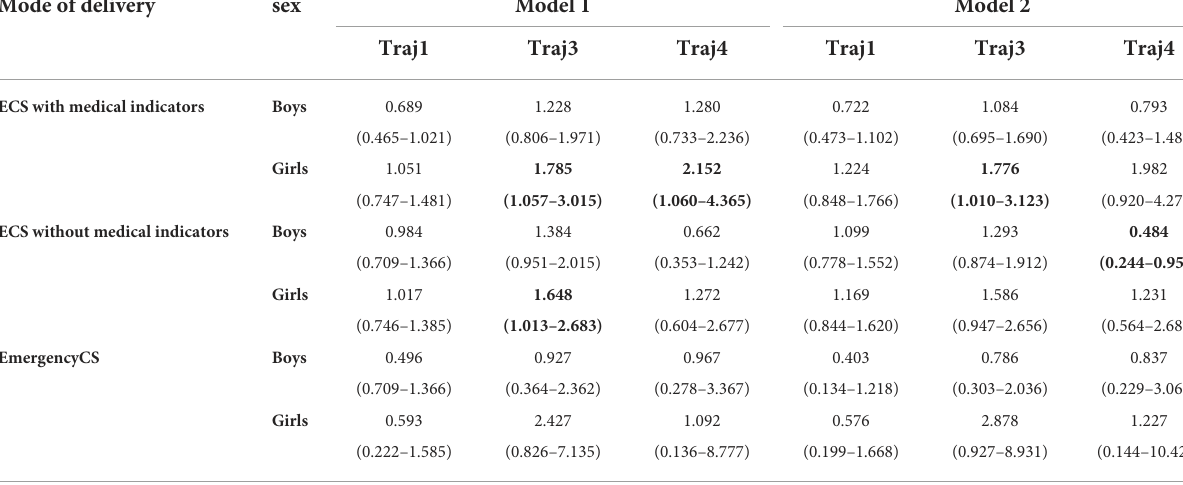
TABLE 3 Association between ECS and children’s growth trajectories in boys and girls [OR (95%CI)]. Mode of delivery